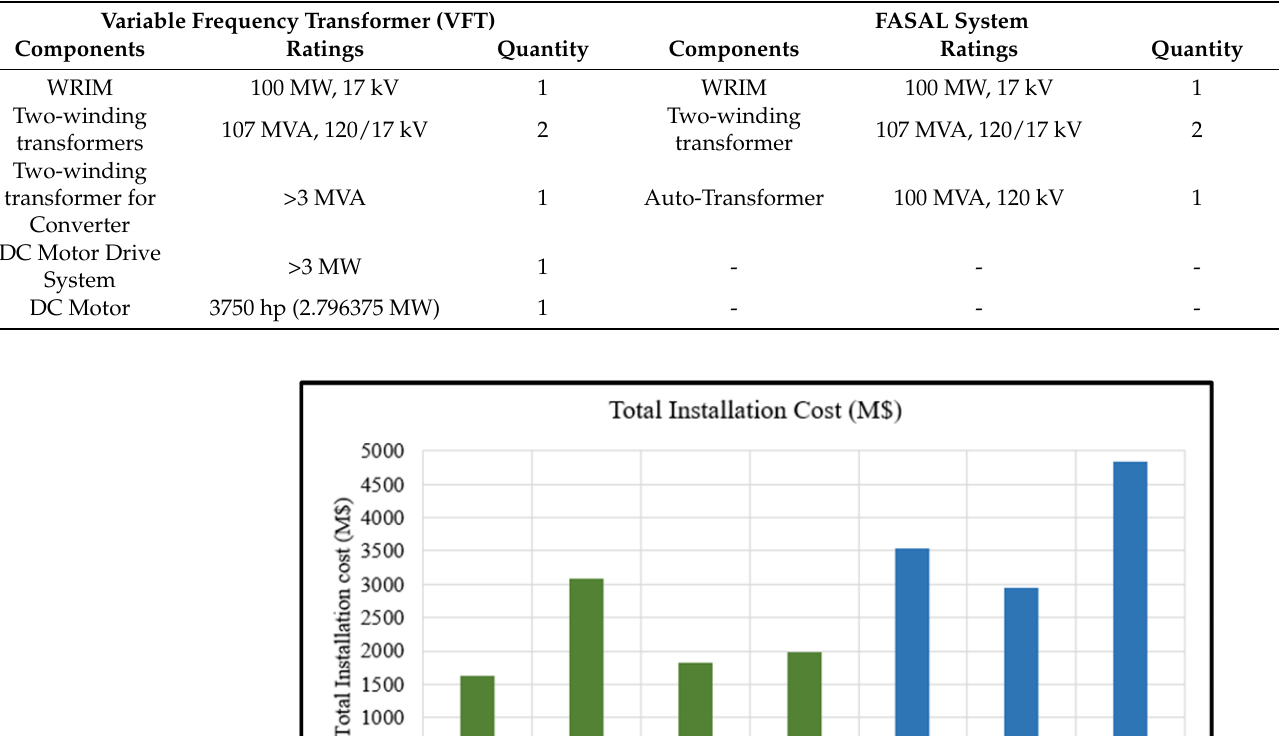
Table 4. Comparative analysis of VFT and FASAL System.